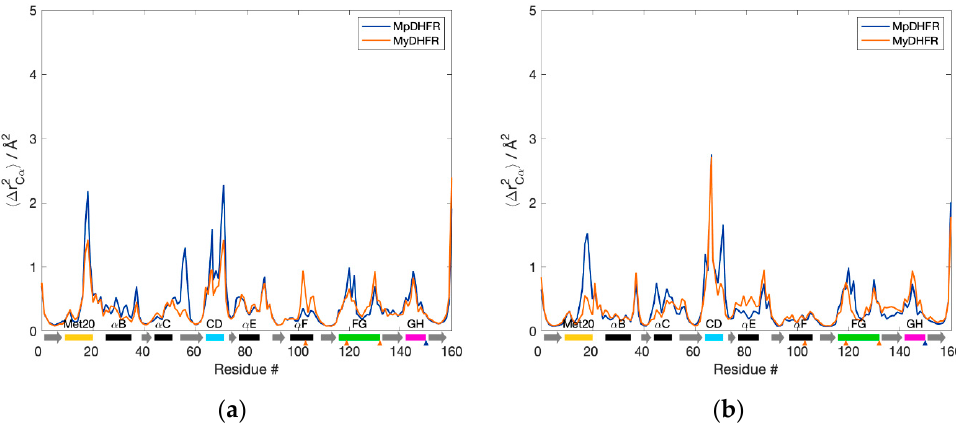
Figure 1. Backbone fluctuations of Moritella DHFRs for the 50 ns simulation at ( a ) 1 and ( b ) 800 bar. α -helices (black rectangles), β -strands (gray arrows), and loops (colored rectangles) are denoted below the axis. Unique residues for MpDHFR (blue) and MyDHFR (orange) are noted with triangles below the axis.